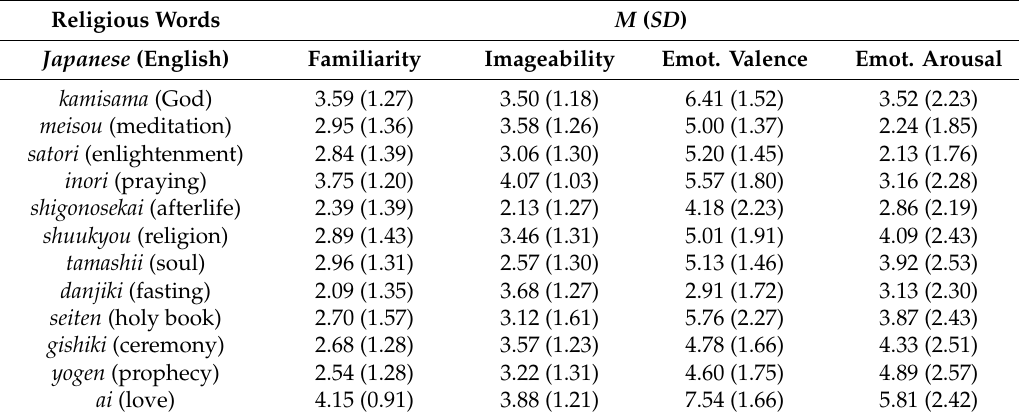
Table 1. Mean scores and standard deviations of psycholinguistic features of religious